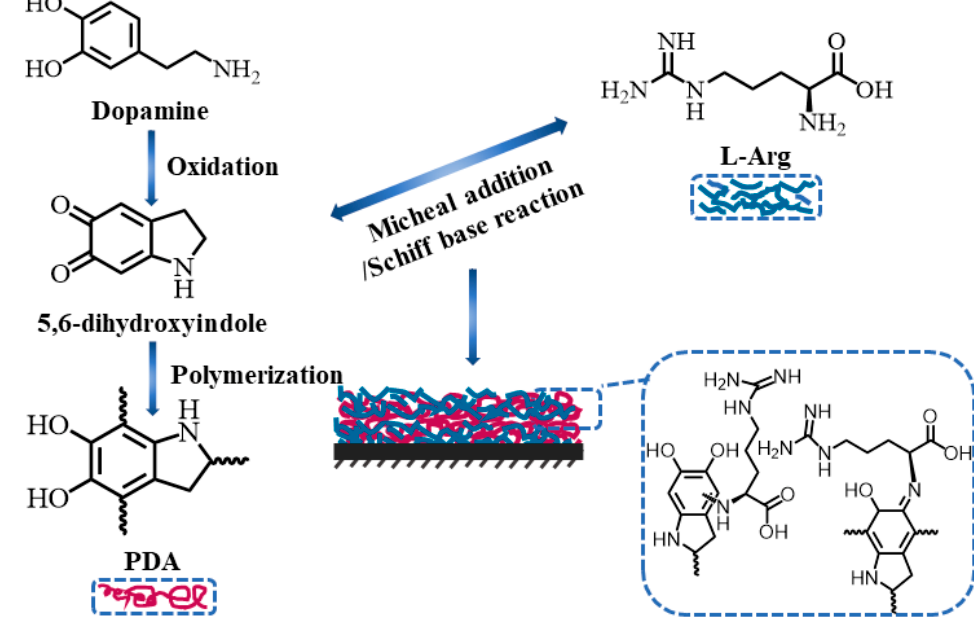
Figure 1. Schematic of the hydrothermal-assisted preparation of PDA/L-Arg@capillary.